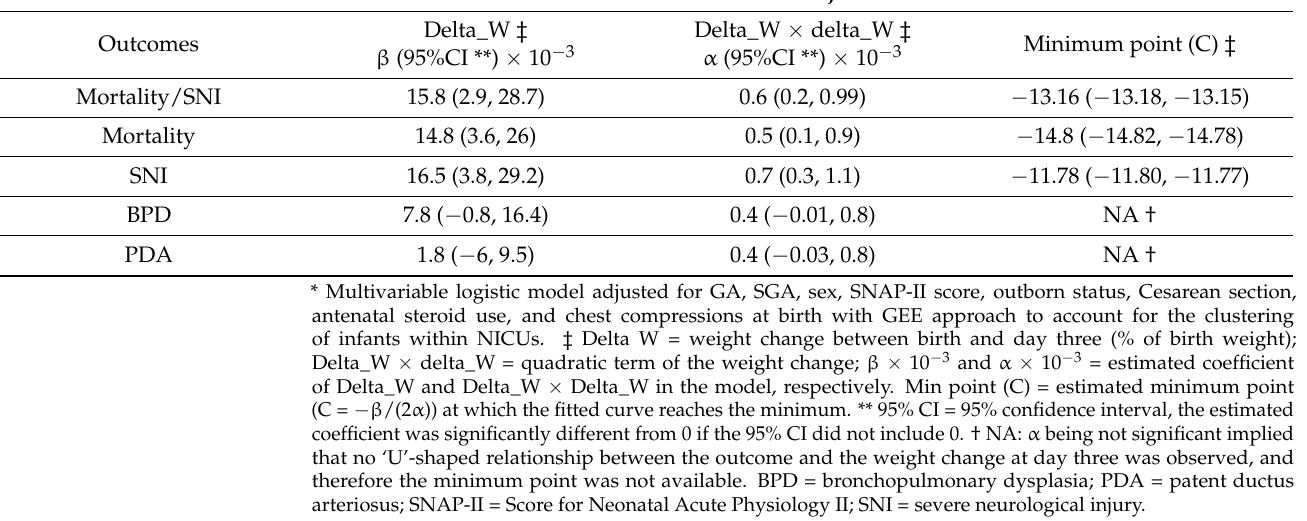
Table 4. Association between outcomes and weight change (% of birth weight) at day 3 from birth. Model with Adjustment *